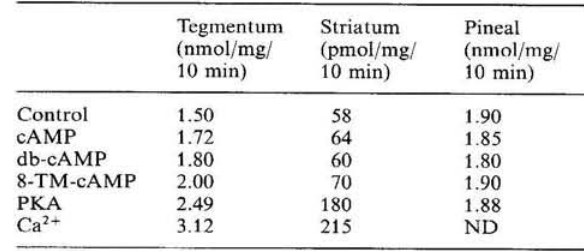
Table 1. Effect of cyclic nucleotides and protein kinase A on the activity of tryptophan hydroxylase in brain and pineal. Tegmentum Striatum Pineal (nmol/mg/